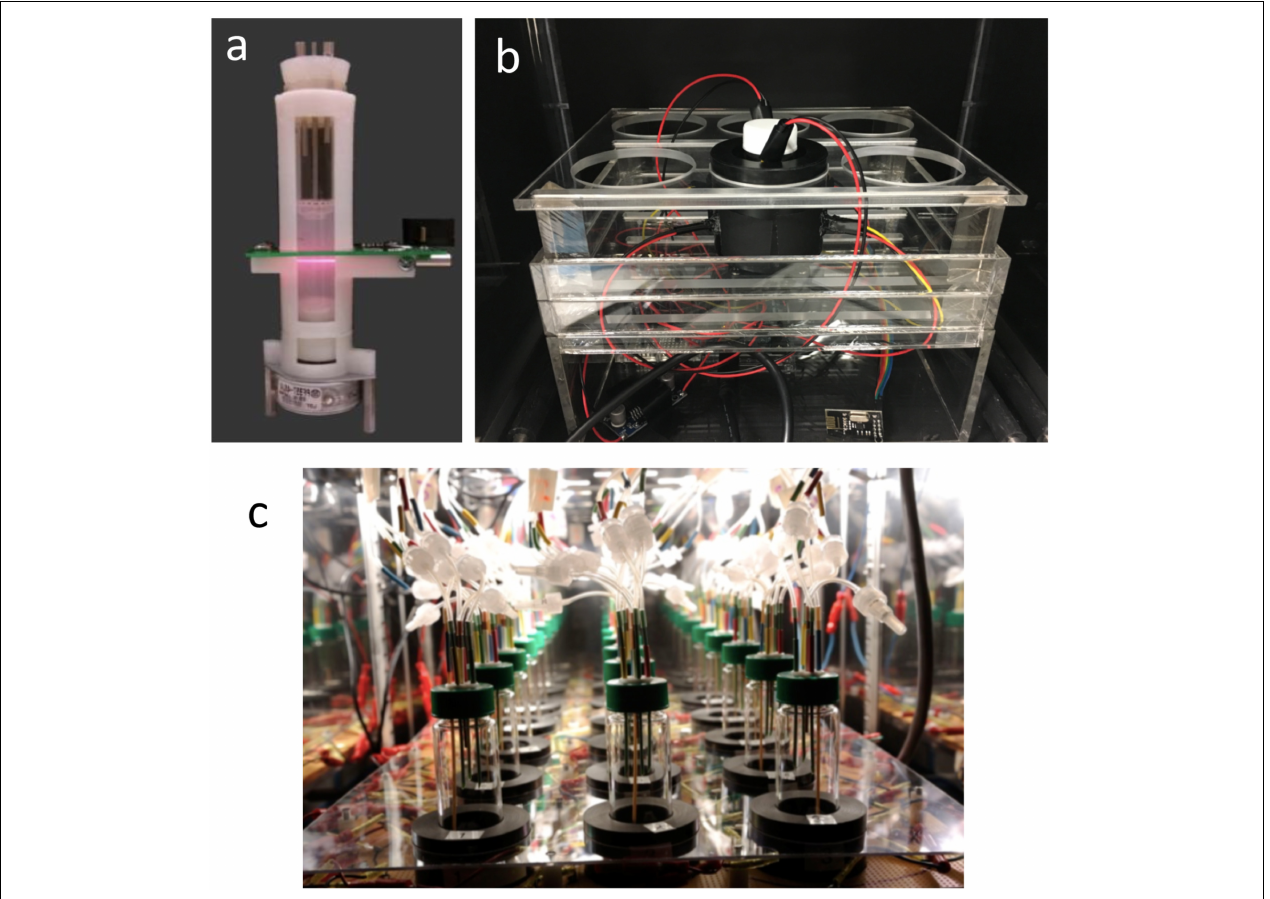
FIGURE 1 | Custom bioreactors for synthetic and system biology. (a) “Turbidostat” built from the 3D printed holder with a laser diode and photodetector installed for optical density measurement (Takahashi et al., 2014). The culture vial is connected to a 3D printed syringe pump to enact the turbidostat mode. ©American Society of Chemistry. Reproduced with permission. (b) Optogenetic mini photo bioreactor (Wang and Yang, 2017). The device integrates light source for control of gene expression and optical density and fluorescence detection for monitoring microbial growth and gene expression. © American Society of Chemistry. Reproduced with permission. (c) Morbidostat built for adaptive laboratory evolution (Toprak et al., 2012). The device integrates optical density measurements for monitoring bacterial cell concentration and implements a feedback algorithm to adjust the drug concentration delivered via the tubing connected to the vessel from the top ( Figure 3C gives the feedback scheme). © Nature Publishing Group. Reproduced with